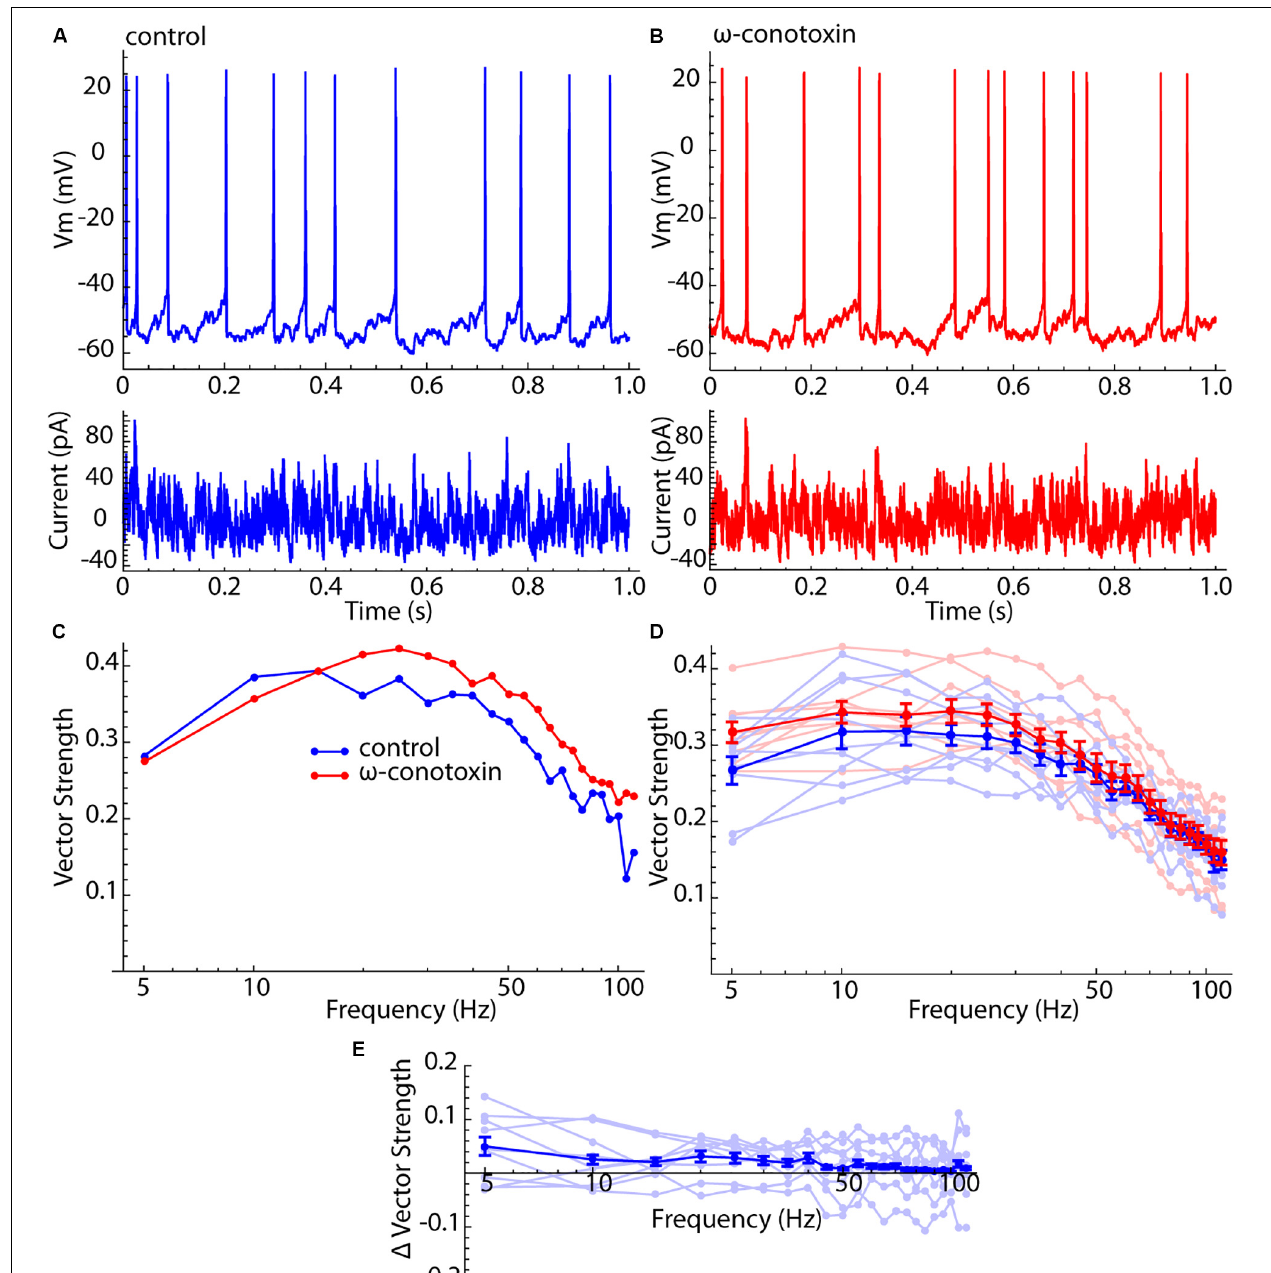
FIGURE 4 | Lack of effect of Cav2 channel blockade on spiking resonance in LTS interneurons. (A) Current waveform, membrane potential, and firing pattern for an example LTS interneuron. (B) The same example neuron after treatment with 1 µ M ω -conotoxin GVIA. (C) Spiking resonance spectra for an example LTS interneuron before (blue) and after (red) conotoxin treatment. (D) Superimposed spectra for all cells before (light blue) and after (light red) conotoxin treatment, and the mean spectra. Error bars are standard errors of the mean. (E) Difference spectra (conotoxin – control) for each cell before and after conotoxin treatment (light blue) and the mean difference spectrum. There was no significant frequency trend for the difference spectra ( F = 0.68, df = 8,21, p = 0.85).